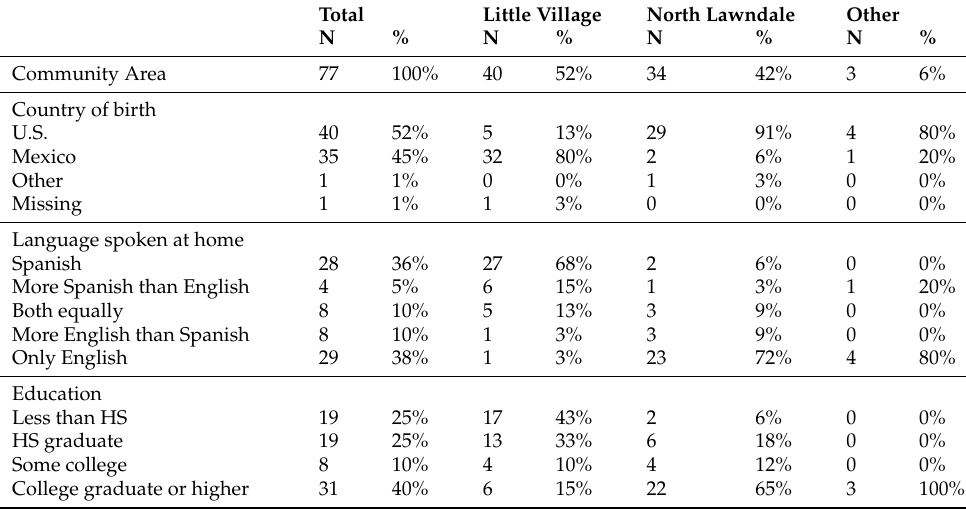
Table 2. Focus Group Participant Characteristics.